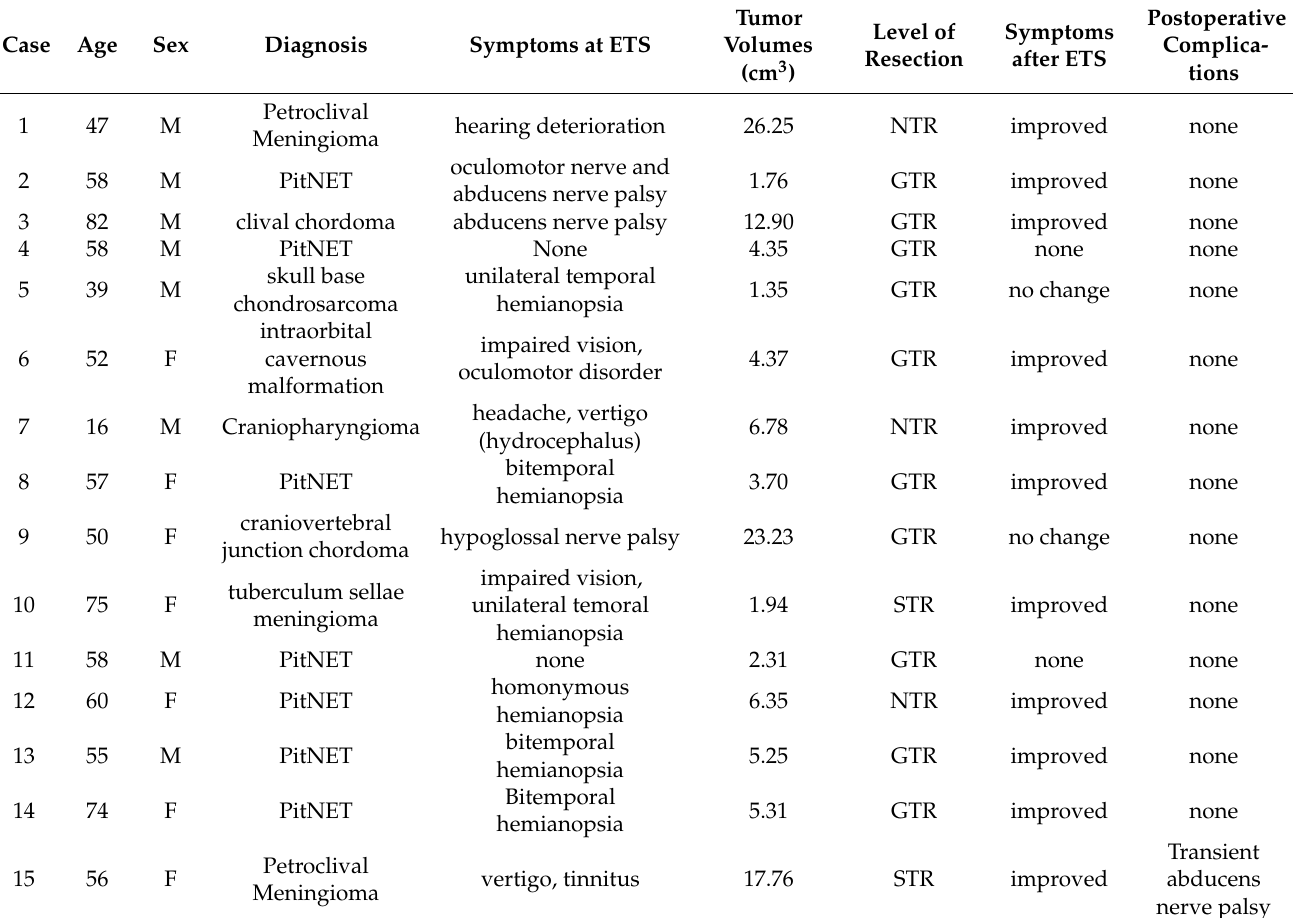
Table 4. Patient